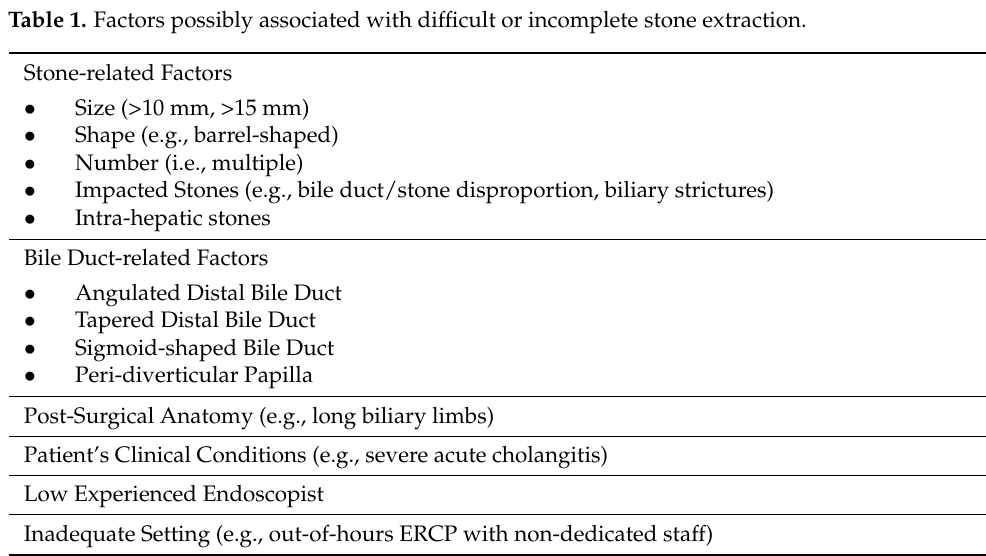
Figure 2. ( A , B ) cholangiograms showing multiple and large common bile duct stones; ( C , D ) fluor- oscopy showing mechanical lithotripsy with basket of the largest stones; ( E , F ) final occlusive chol- angiograms showing complete clearance of the bile duct after lithotripsy and extraction of frag- ments.